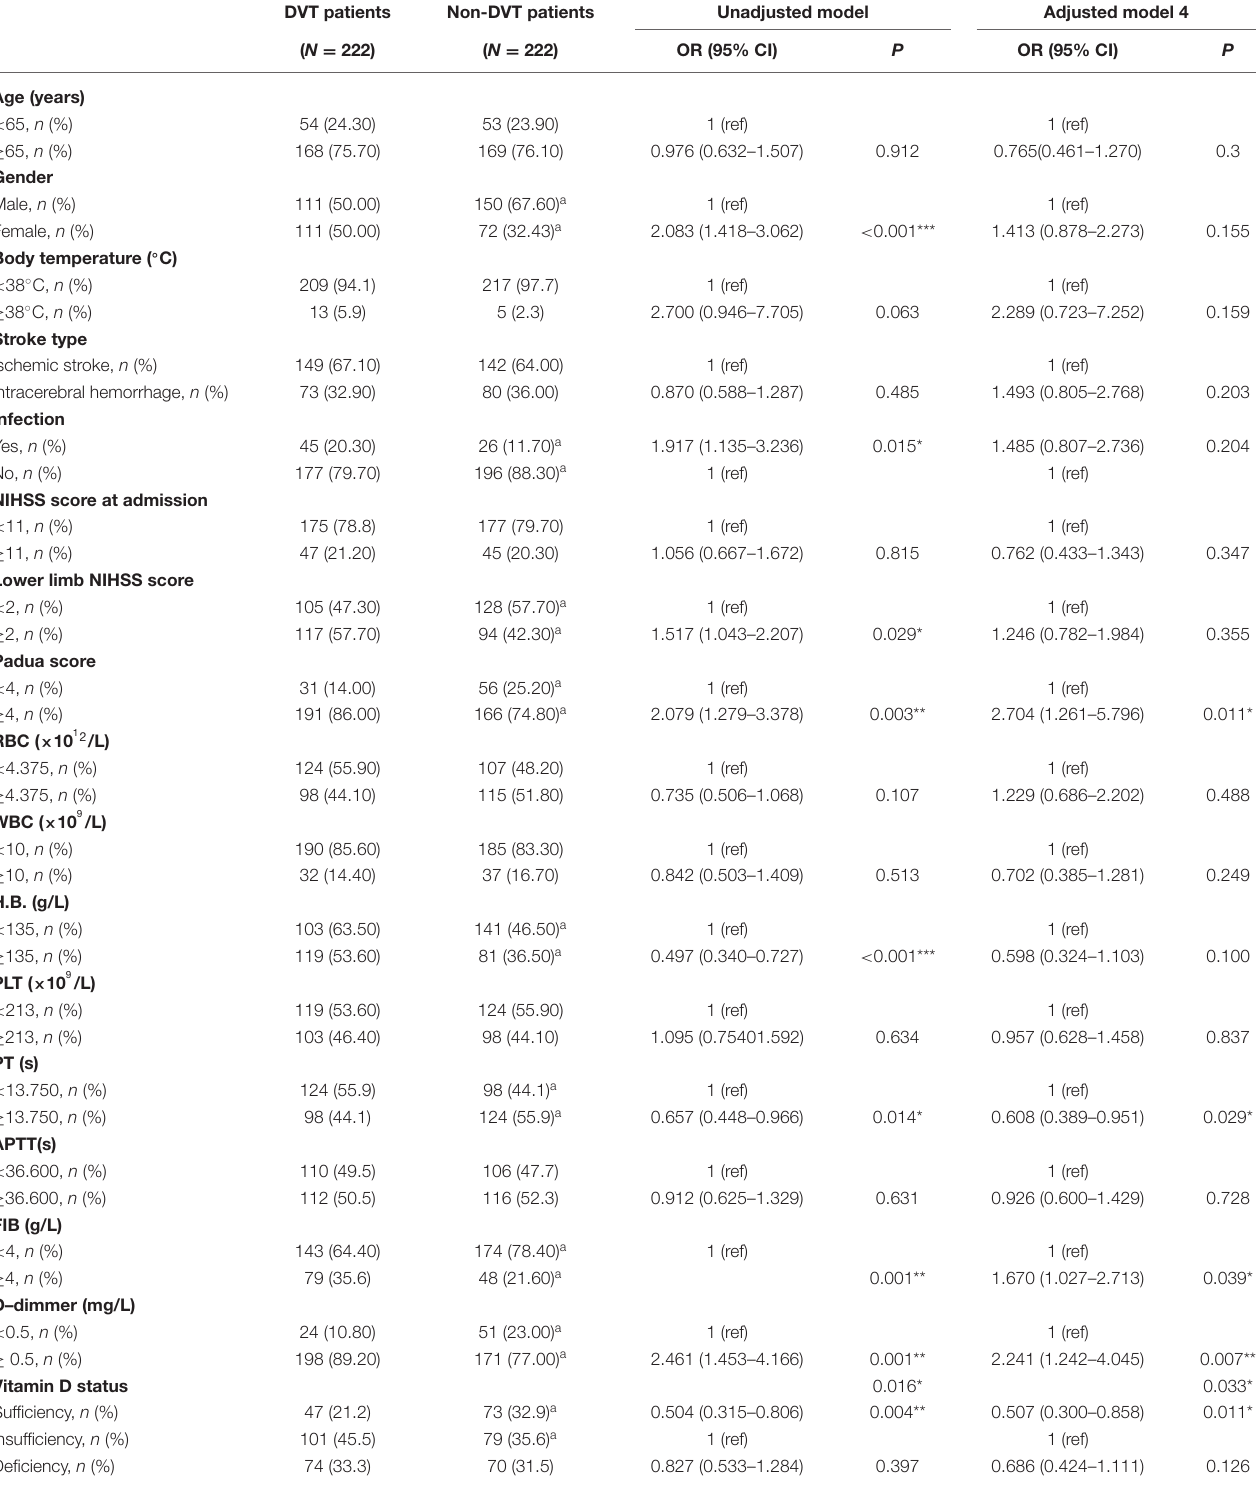
TABLE 4 | Stratified variables of stroke patients and binary logistic regression model testing predicting the value of variables with IDDVT. DVT